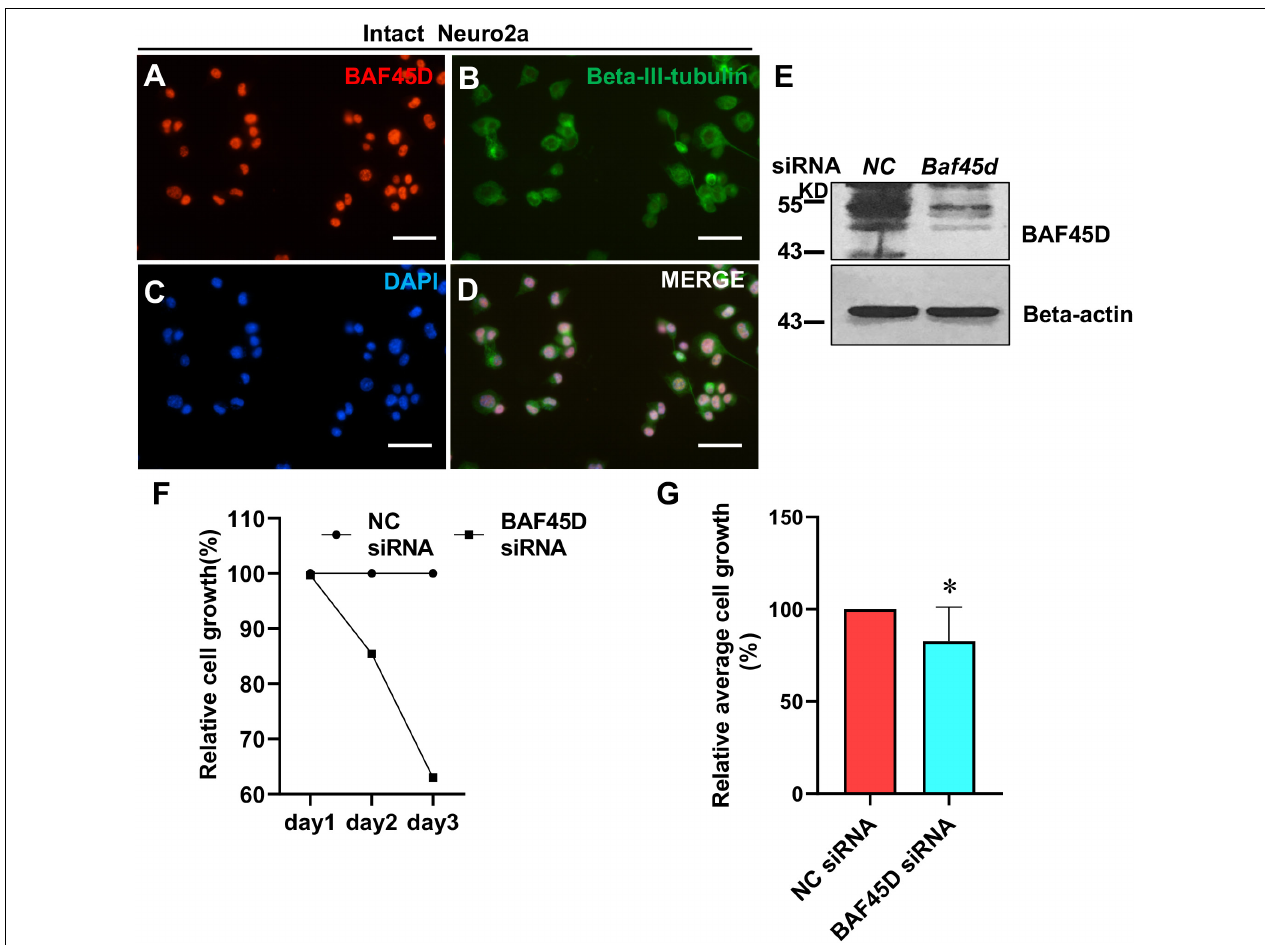
FIGURE 8 | The knockdown of BAF45D inhibited cell growth in neuro2a cells. (A–D) Neuro2a cells were subjected to IF assays using anti-BAF45D and anti-beta-III-tubulin antibodies. Scale bar: 25 µ m. (E) Expression of BAF45D and beta-actin was examined by IB assays using the indicated antibodies. (F) The total cell number in the NC siRNA group was defined as 100%. The cell numbers in the Baf45d siRNA group are shown as relative cell growth. (G) Mean cell growth in neuro2a cells. ∗ P < 0.05, compared with that in the NC group. Statistical analysis involved the Mann–Whitney U -test and was carried out using SPSS 17.0 software.